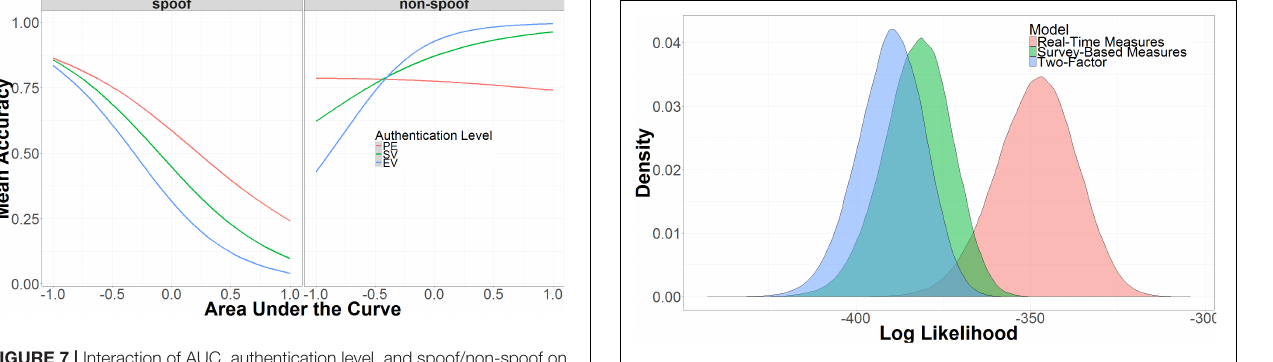
FIGURE 9 | Expected log predictive density taken from posterior samples in 10-fold cross